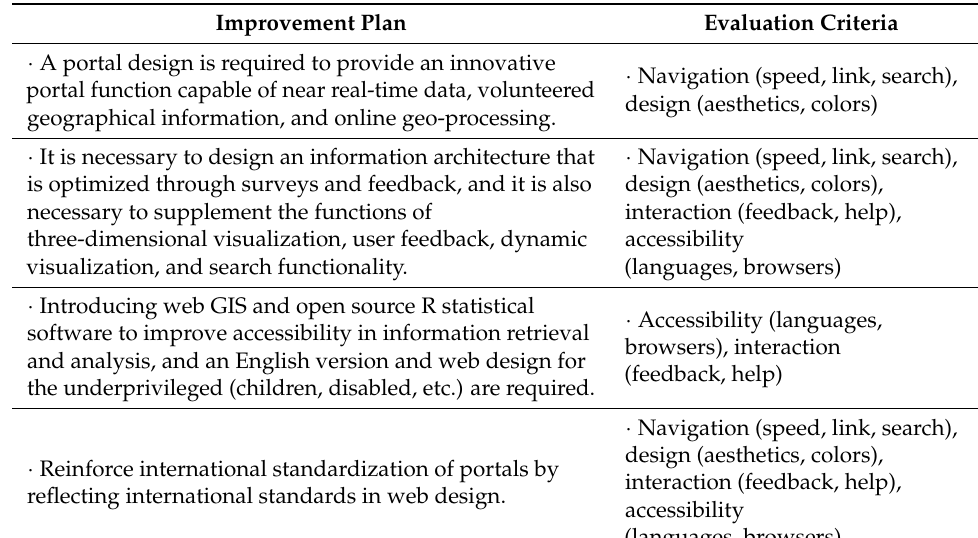
Table 9. Improvement plan for website